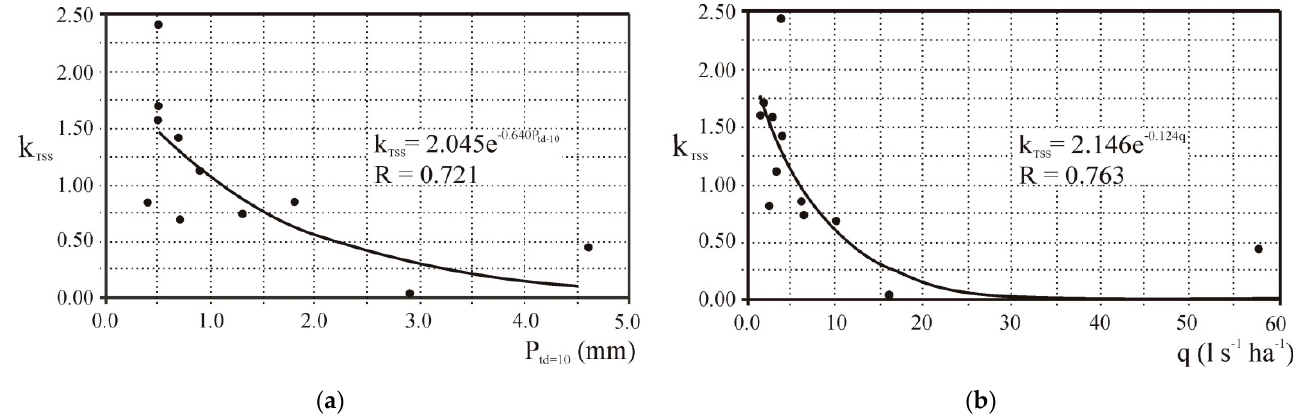
Figure 6. Dependence of the washout coefficient ( k TSS ) on: ( a ) 10-min precipitation; ( b ) rainfall intensity.